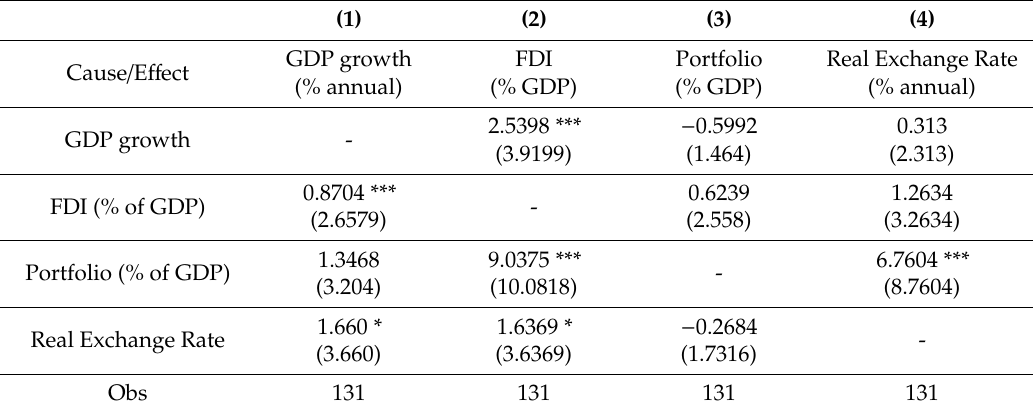
Table 5. Granger bi-directional causality test results: Coe ffi cient is Z-bar, and (.) is the W-bar, lags (2).